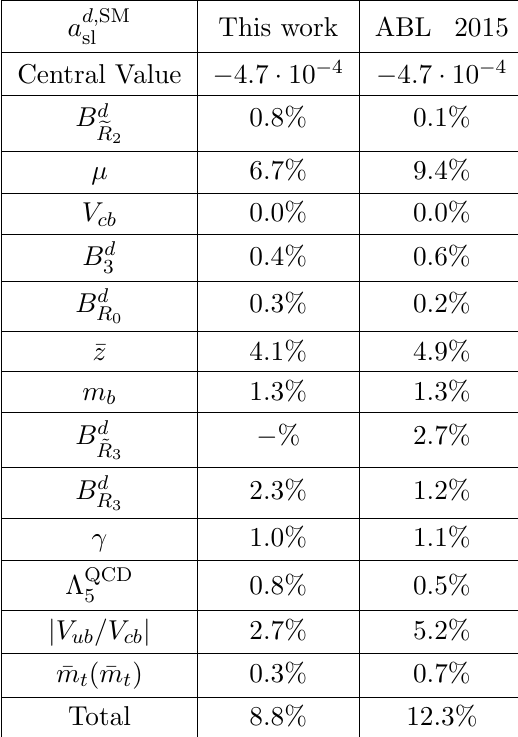
Table 16 . List of the individual contributions to the theoretical error of the mixing quantity a d; SM in the B 0 -sector and comparison with the values obtained in 2015 [31]. We have used equations of motion in the current analysis to get rid of the operator ~ R 3